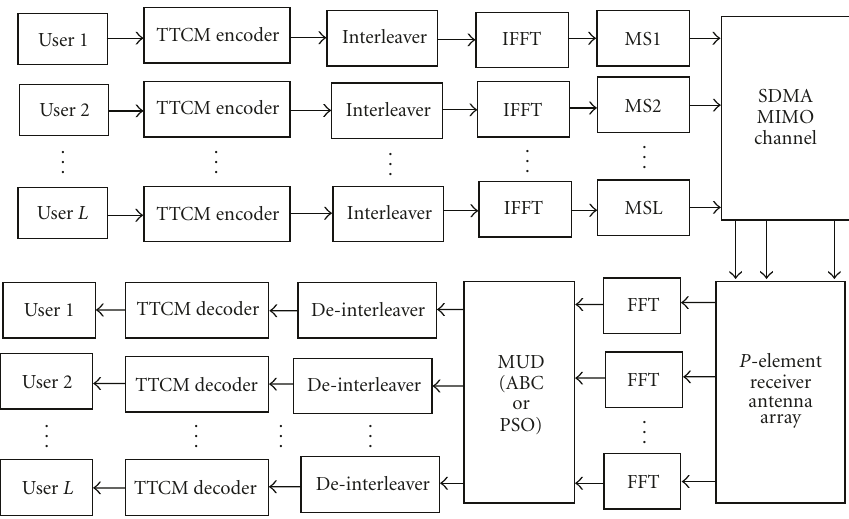
Figure 1: Schematic of TTCM-MMSE-ABC-MUD-SDMA-OFDM uplink